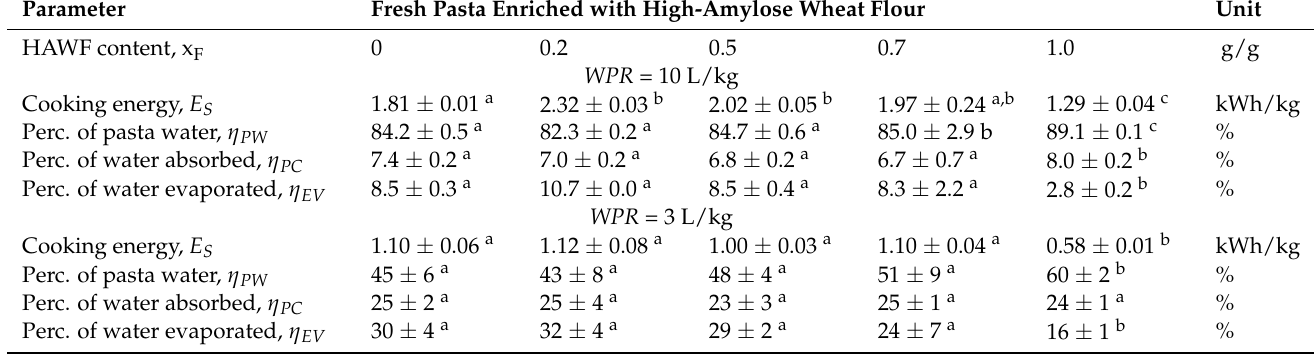
Table 4. Effect of the percentage (x F ) of high-amylose wheat flour in the flour mixture used to prepare fresh pasta samples on the cooking energy needs (E S ) and distribution of cooking water when using different water-to-pasta ratios